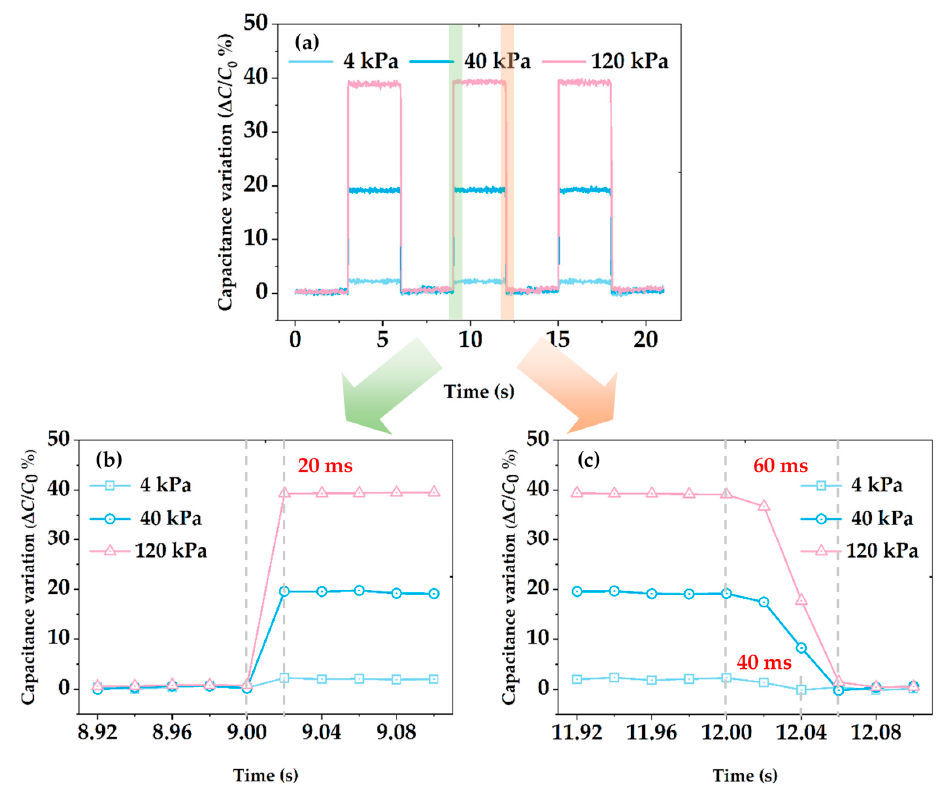
Figure 7. Time-resolved capacitance change response of the sensor: ( a ) Under repeated external loads with different pressures ranging from 4 to 120 kPa; ( b ) Response time measured during repeated loading; ( c ) Response time measured during repeated unloading.